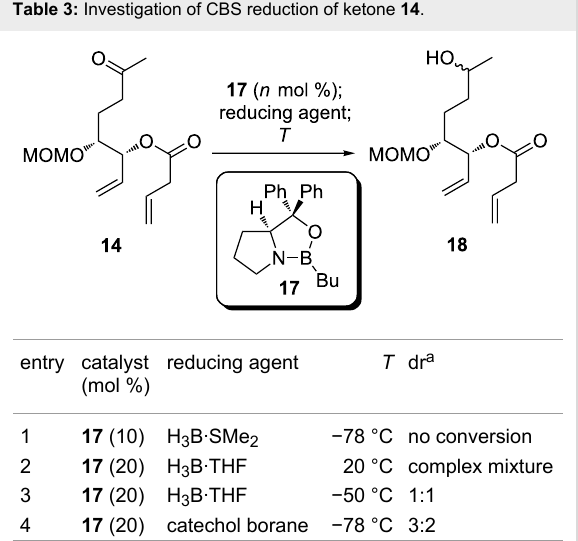
Table 3: Investigation of CBS reduction of ketone 14